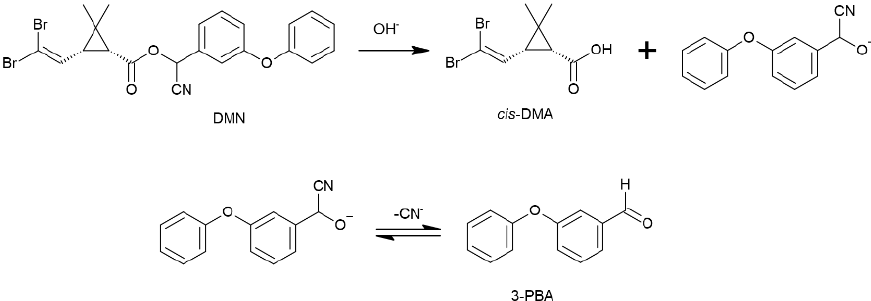
Scheme 1. Basic hydrolysis of DLM with formation of DMA and 3-PBA.